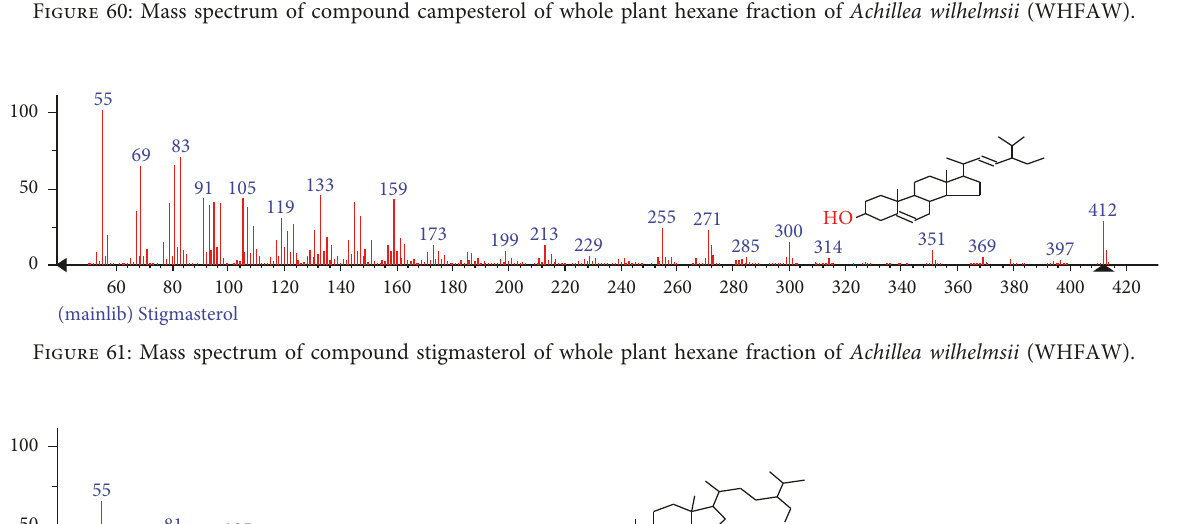
Campesterol60 80 (mainlib) Figure 60: Mass spectrum of compound campesterol of whole plant hexane fraction of Achillea wilhelmsii (WHFAW).